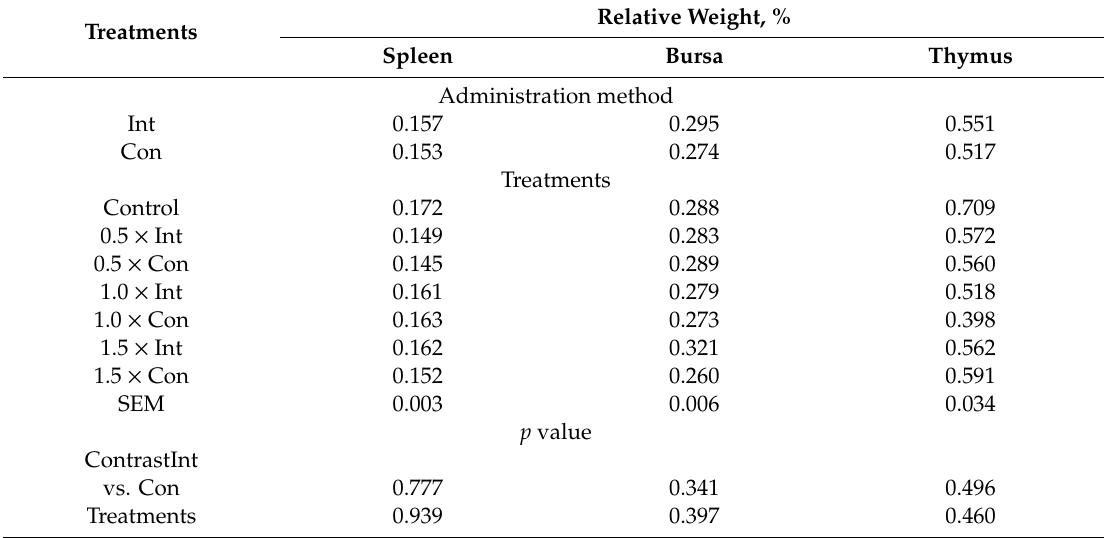
Table 6. E ff ects of multienzymes supplemented continuously or intermittently on lymphoid organs of Arbor Acres broiler chicks during 1–35 days of age.